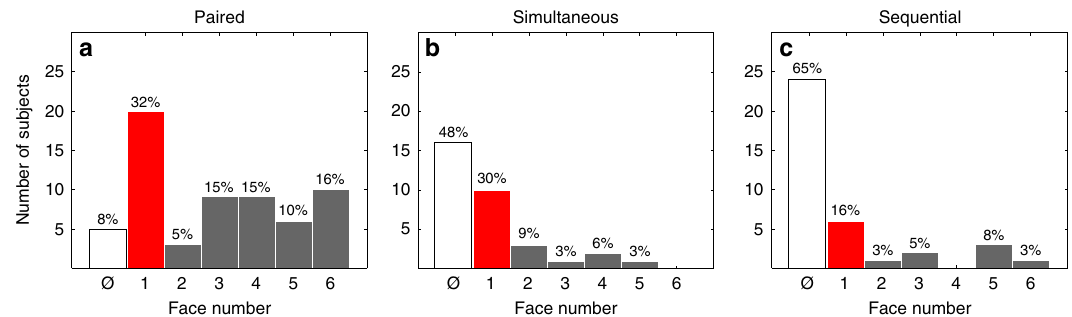
Fig. 3 Results of three lineup procedures. Frequency distributions of subjects selecting the six faces used in three target-present lineups: paired comparisons (PAR; N = 62 subjects) in ( a ), simultaneous (SIM; N = 33 subjects) in ( b ), and sequential (SEQ; N = 37 subjects) in ( c ). Symbol ø in the abscissa of every plot represents the outcome in which subjects made no selection (i.e., “ rejected ” the lineup). In every lineup, more subjects correctly selected the target (F1, red bar) than other faces. Proportion of correct identi fi cations was largest in paired comparison lineup.